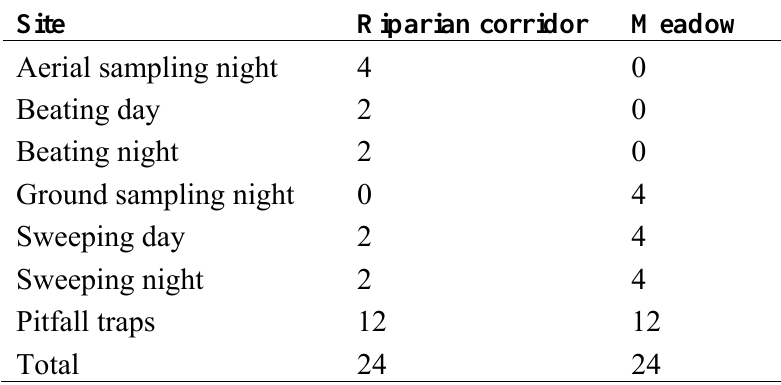
Table 2. Number of samples per method at each plot sampled with the standardized and optimized protocol [19]. Each sample is equivalent to one person-hour of collecting and a pitfall sample is made by 4 pooled traps (for an explanation of methods see [6,8,9]). Most methods were performed on May 11, 2008, except for pitfall traps which were left in the field from 14 to 28 of May,